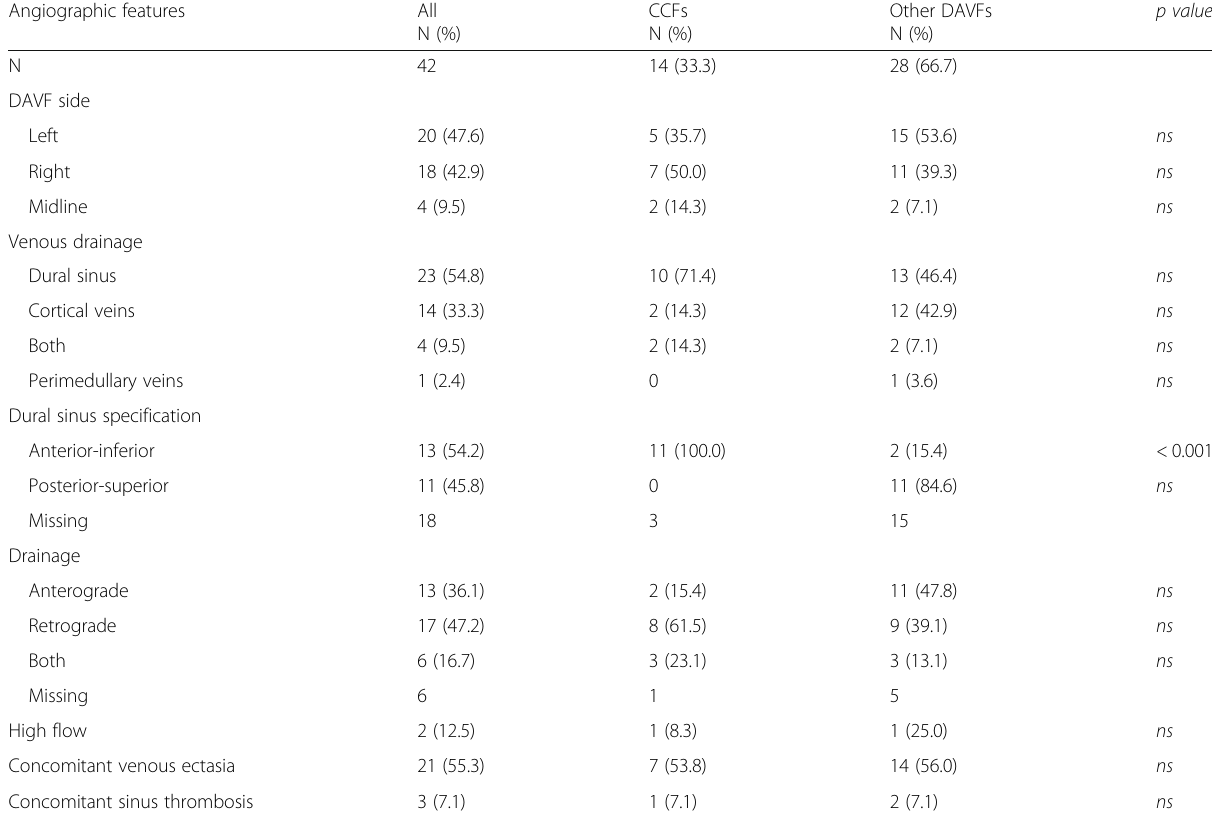
Table 4 Angiographic features